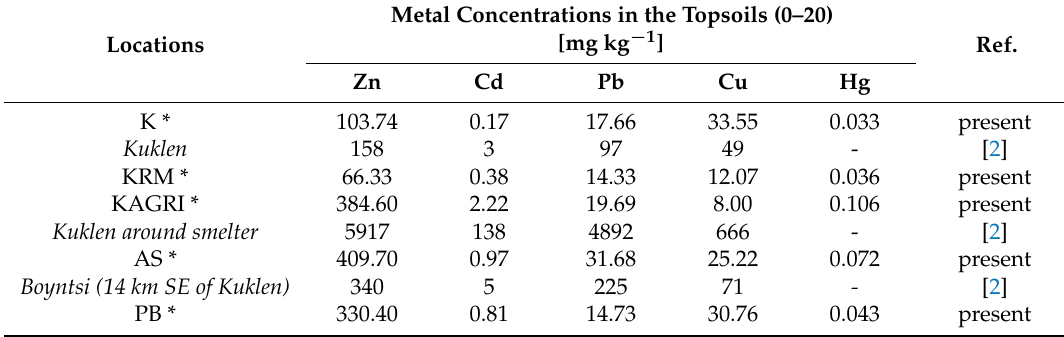
Table 4. Comparison of toxic metal pollution in the vicinity of the non-ferrous smelter for different time